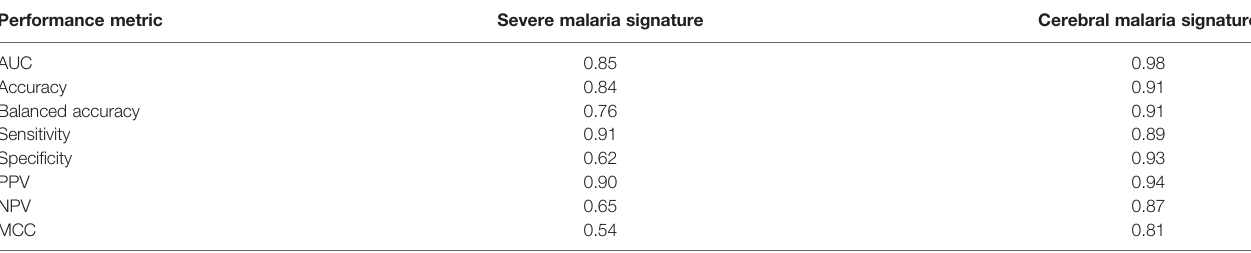
TABLE 2 | Complete performance of the severe and cerebral malaria signatures in the testing data.